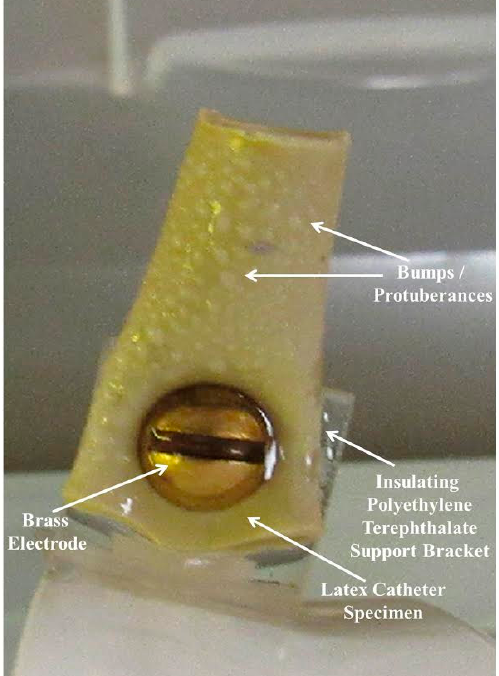
Figure 2. Sample 3 (from trial #1) with brass electrode, showing bumps/protuberances on its front face.